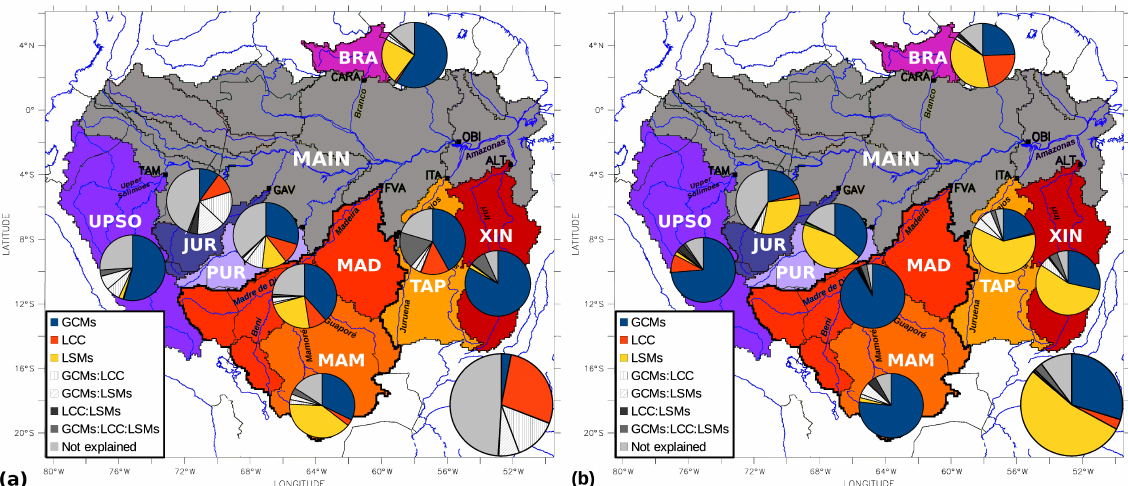
Figure 14. Contributions of GCMs, LCC scenarios, LSMs and interactions between each to total uncertainty in (a) ET and (b) runoff changes, for the end of the century, for the Amazon Basin (bottom right pie chart) and eight of its